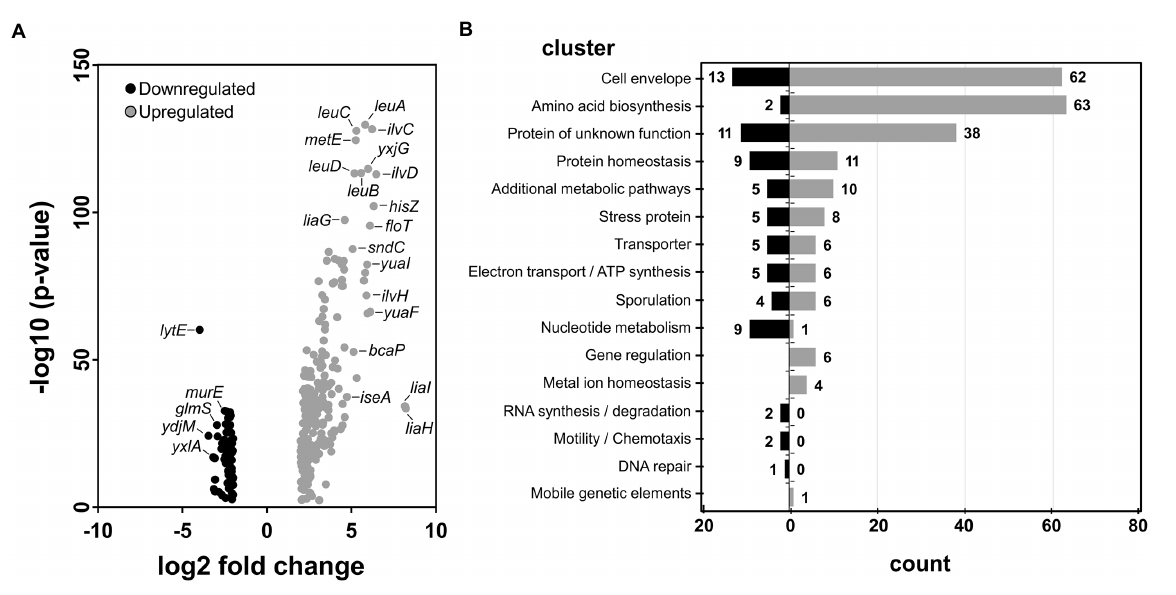
FIGURE 2 RNA-seq results upon BDTL049 treatment. (A) Volcano plot of differential expressed Bacillus subtilis genes. (B) Genes in (A) were clustered according to their Subtiwiki (Zhu and Stulke, 2018) classification. Upregulated genes are marked in light gray whereas downregulated genes are highlighted in black. For applied cut-off values regarding significance see the section “Materials and